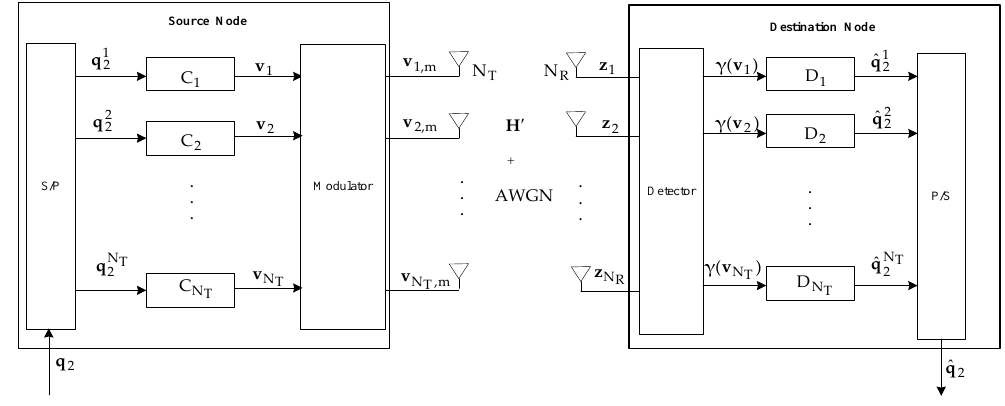
Figure 5. Non-cooperative ATC-VBLAST (Vertical Bell Labs Layered Space-Time) scheme.